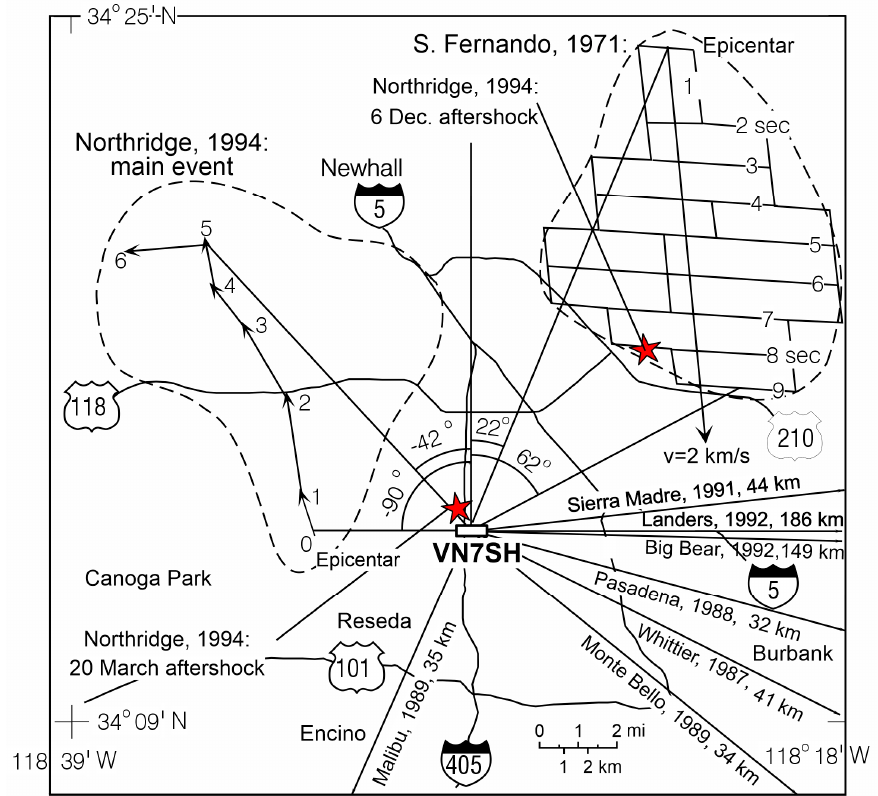
Figure 1. Location of Van Nuys seven-story hotel (VN7SH) and relative to the faults of the 1971 San Fernando and 1994 Northridge, California, earthquakes and other earthquakes recorded in the building [18].